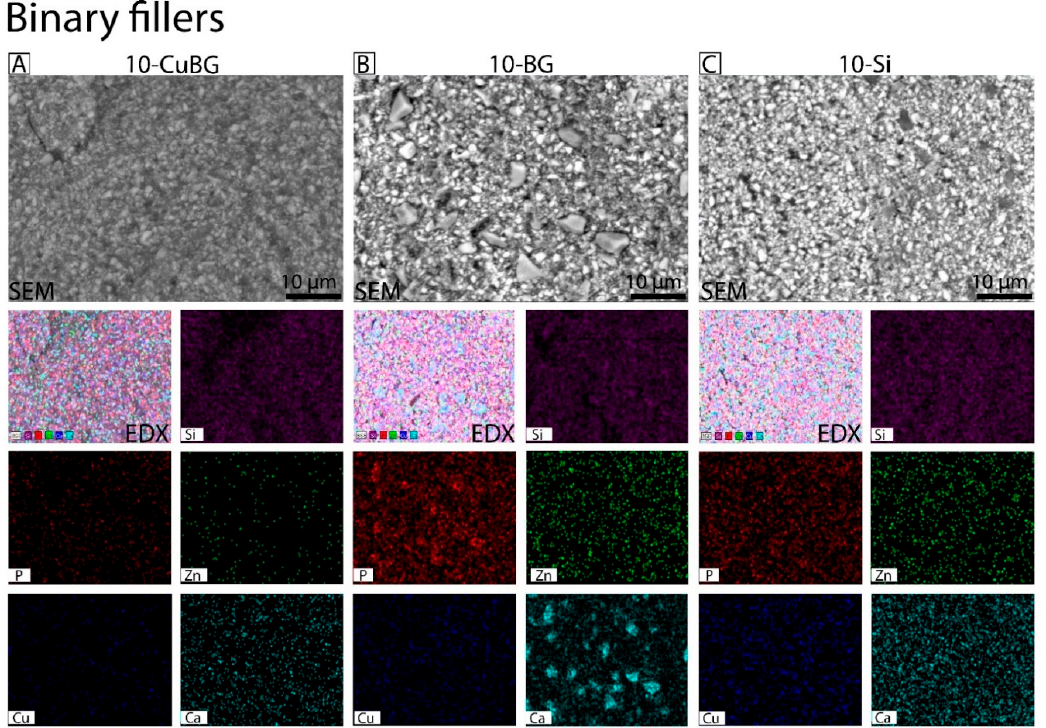
Figure 1. Representative surface morphology and elemental mapping images of the Binary filler group by SEM-EDX. ( A ) 10-CuBG, ( B ) 10-BG, and ( C ) 10-Si. SEM-EDX images were taken after 28 days of experimental composites immersed in HEPES buffer (pH = 6.5), and the elements identified were silica (Si) in purple, phosphorous (P) in red, zinc (Zn) in green, copper (Cu) in blue and calcium (Ca) in light blue. Scale bar corresponds to 10 μ m in all micrographs.